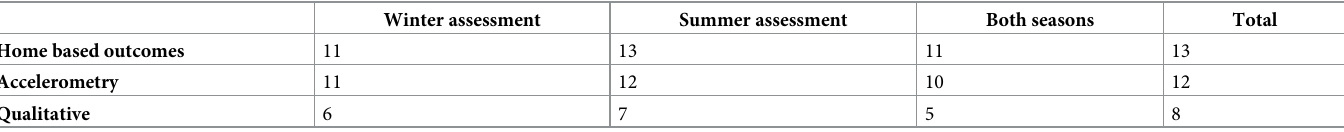
Table 2. Summary of participants involved in each aspect of the study.